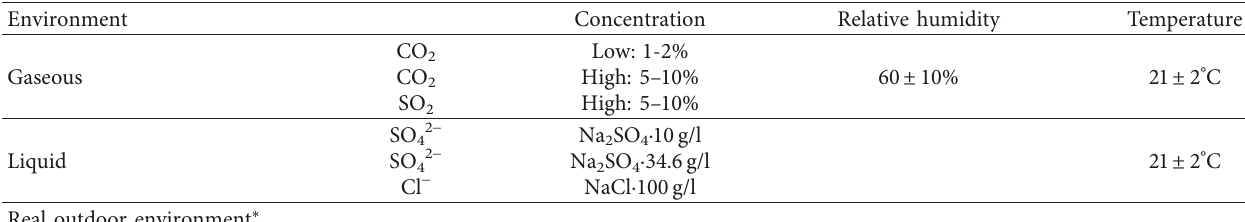
Figure 4: X-ray diffraction analysis of crystalline admixture. Table 5: Description of aggressive